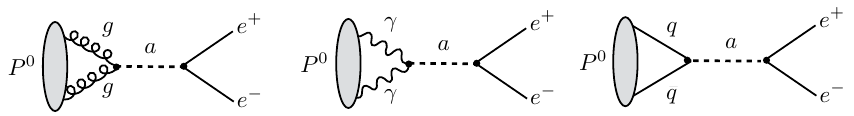
Figure 31 . ALP-induced contributions to the P 0 → ‘ + ‘ − decay